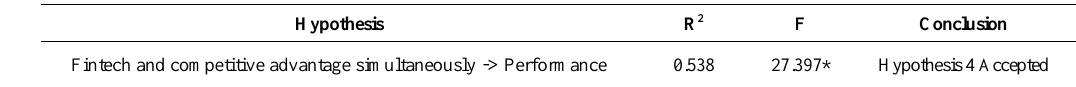
Table 4. Simultaneous hypothesis